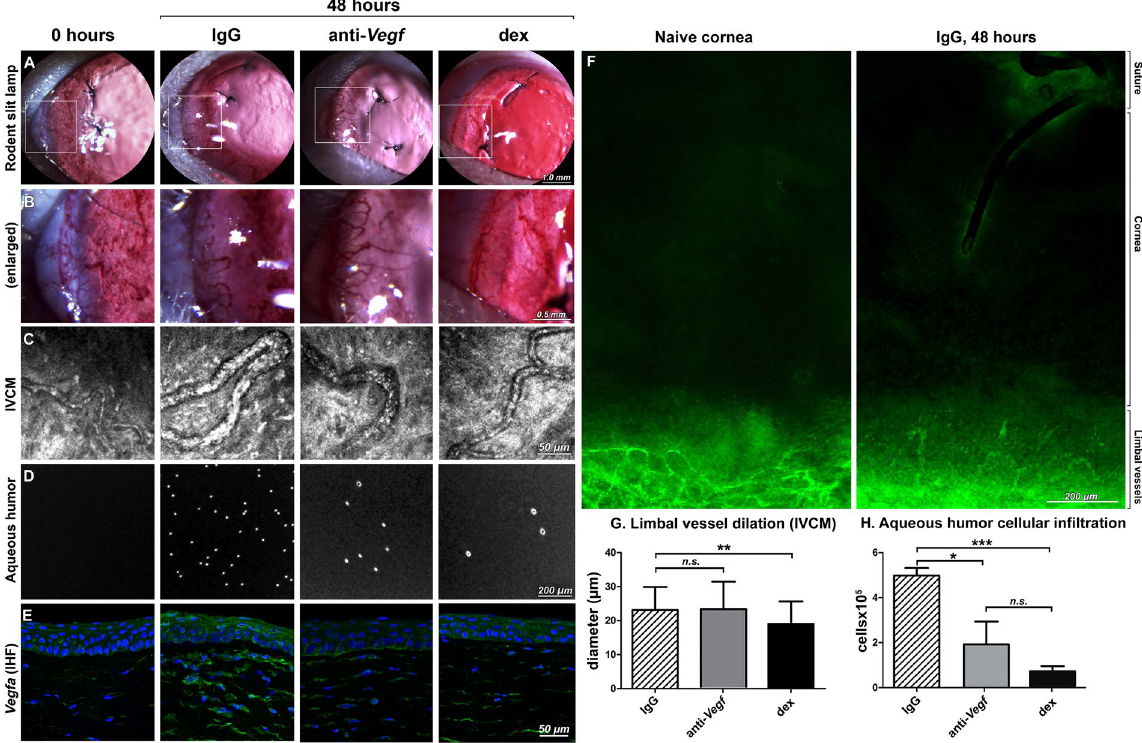
Figure 1. Limbal vessel dilation, inflammatory cell infiltration and Vegfa expression following IgG, anti- Vegf and dexamethasone treatment of suture-induced injury in the rat cornea. ( A ) Slit lamp photographs depicting limbal vessel dilation and looping angiogenesis 35 48 h after suture placement in IgG and anti- Vegf groups, not detected in the dexamethasone group; expanded view of the white boxed area in ( B ). ( C ) IVCM images of limbal vessel dilation, and the corresponding measurements of limbal vessel diameter in ( G ); ( D ) Microscopic images of aqueous humor cellular content, and the corresponding quantification in ( H ). ( E ) Immunofluorescence of Vegfa (green) and DAPI counterstaining of nuclei (blue) in corneal tissue sections. ( F ) CD31 staining (green) of naïve and sutured cornea at 48 hours: the latter shows no sign of corneal neovascularization. n = 4 corneas per group for ( G) and ( H) , * P < 0.05; ** P < 0.01; *** P < 0.001; n.s. = P > 0.05 and error bars represent